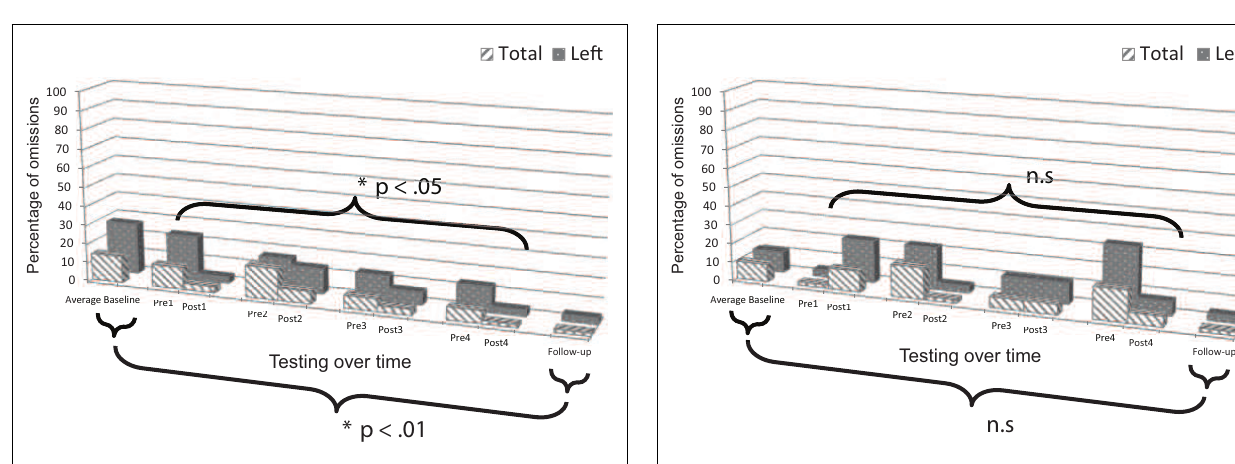
FIGURE 5 | Plot of Patient 2’s average baseline, intervention period, and follow-up responses on the Mesulam shape cancellation test .